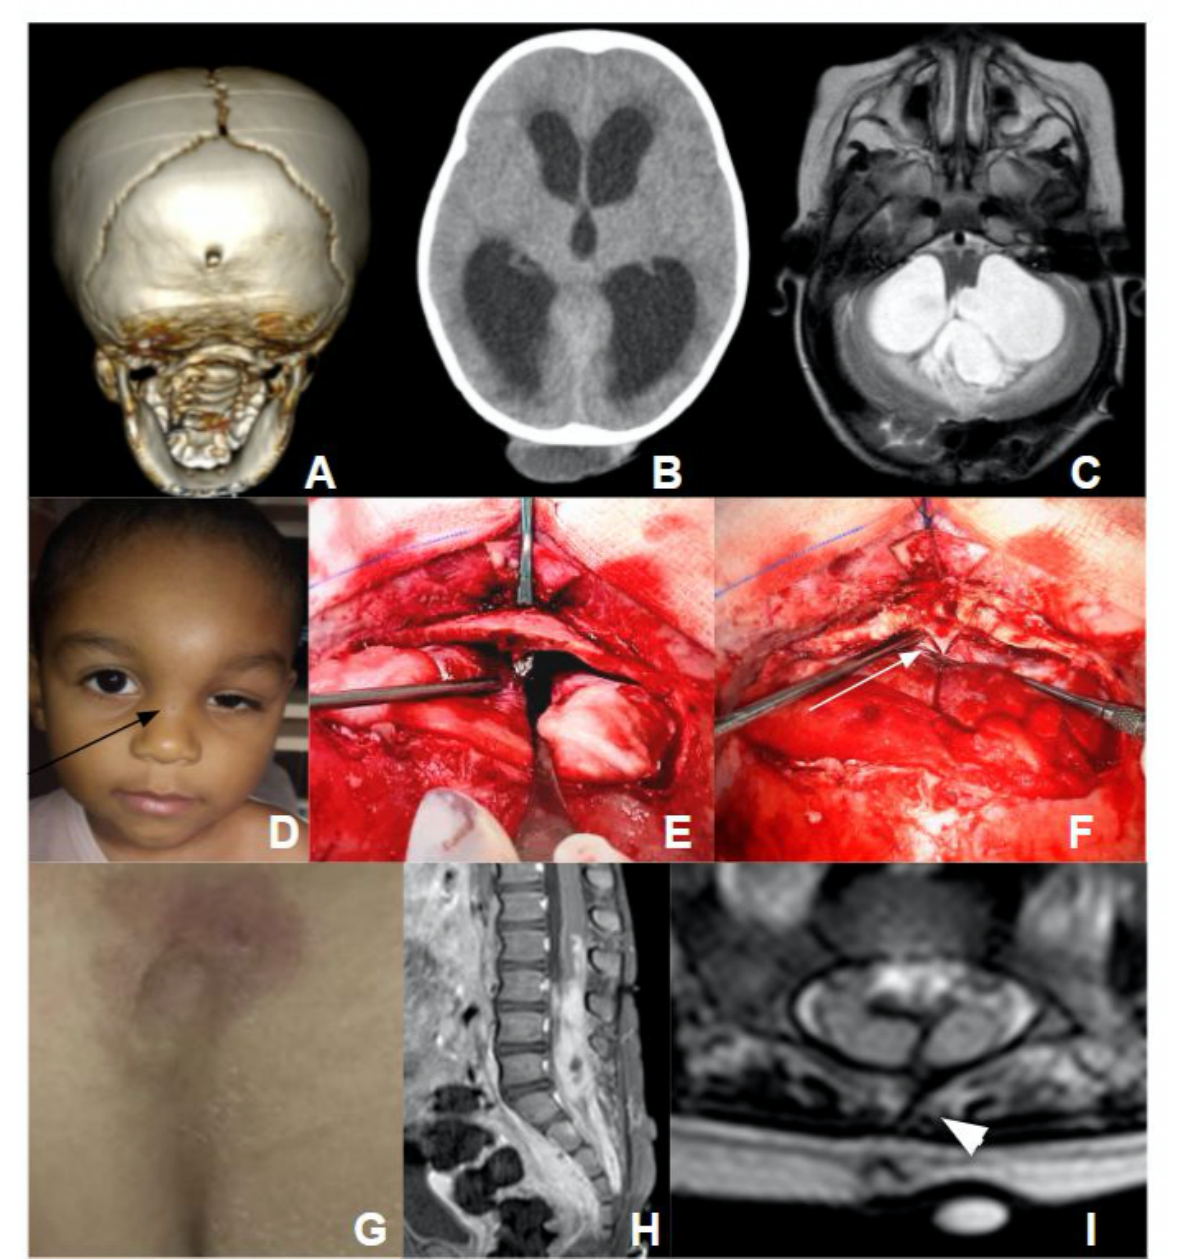
Figure 1 - Cases of CDS. Case 1 (A-C), A) 3D CT-scan reconstruction with occipital bone defect where the CDS tract was passing through, B) Axial CT-scan with hydrocephalus, C) Axial T1 MRI showing dermoid cyst in the posterior fossa. Case 2 (D-F) D)Presentation with left ptosis due to periorbital cellulitis and frontal building over a small hairy pit (black arrow) in the nasal region. E) Frontal craniotomy with dissector in the patent foramem ceacum. F) CDS tract in contact with dura (white arrow). Case 3 (G-I), G) Patient’s cutaneous stigmas: dimple, hypertrichosis and hemangioma. H) MRI in T1 sagittal sequence with contrast enhancement showing important intraspinal empyema. I) MRI in T1 axial sequence with contrast enhancement showing dermal sinus tract (white head